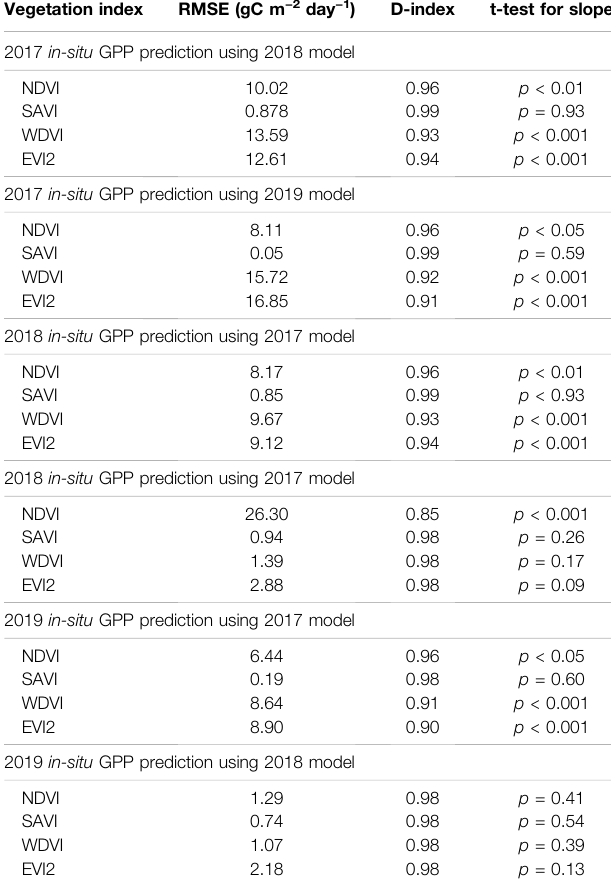
TABLE 2 | Summary of the statistical analysis (RMSE, d-index, and results of t-test) of the performance of gross primary production (GPP) models comparing predicted versus eddy covariance-based in-situ GPP (gC m − 2 day − 1 ). The t-test compared the slope of the regression line to 1.0, with p values less than 0.05 indicating a slope signi fi cantly different from 1.0. Vegetation indices used for developing GPP prediction models include normalized difference vegetation index (NDVI), soil adjusted vegetation index (SAVI), two-band enhanced vegetation index (EVI2), and weighted difference vegetation index